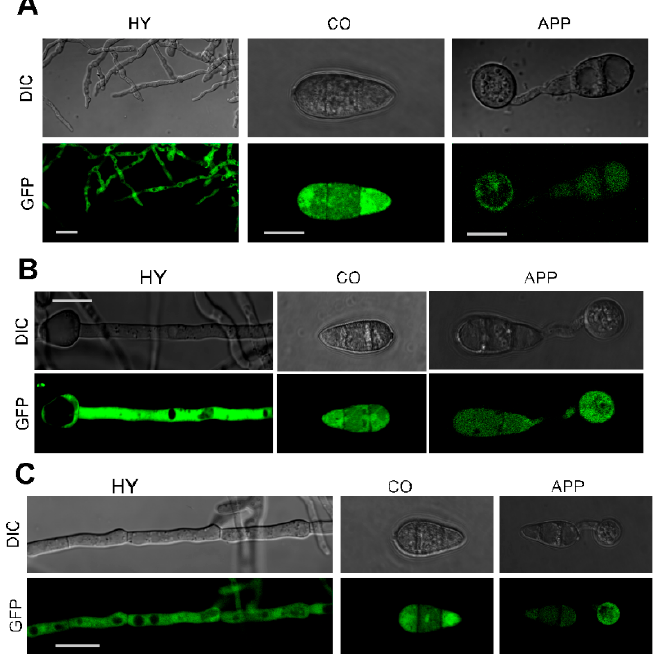
Figure 14. Subcellular localization of MoGln1, MoGln2, and MoGln3 in rice blast fungus. ( A – C ) The localization pattern of MoGln1-GFP, MoGln2-GFP, and MoGln3-GFP in hyphae, conidia, and appressorium. Localization of MoGln1-GFP, MoGln2-GFP, and MoGln3-GFP were examined by Nikon laser confocal, scale bar = 10 μ m, MoGln1-GFP hyphae scale bar = 5 μ m.